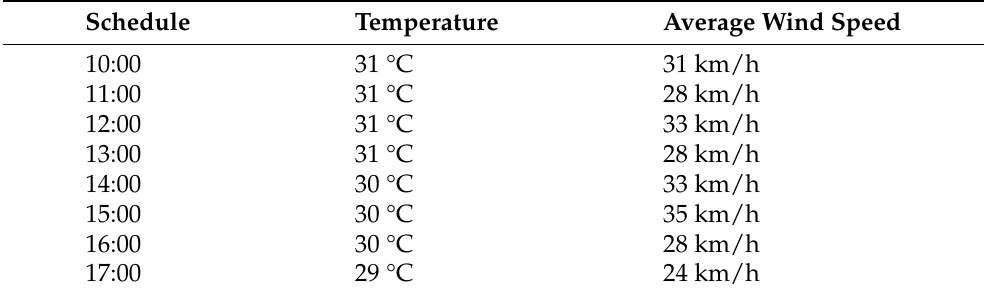
Table 2. Table of temperature and average wind speed on the day of measurement.